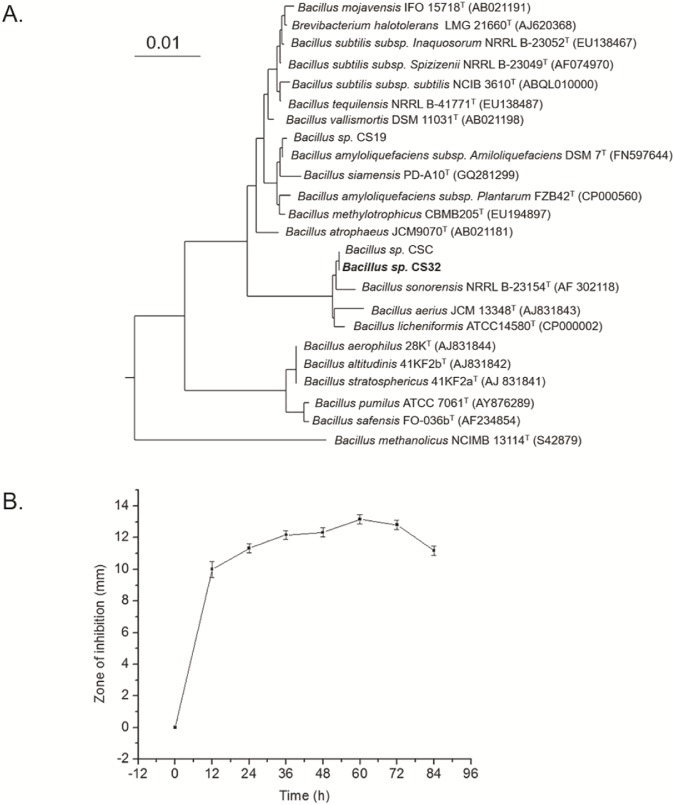
(A) A neighbor-joining tree based on nearly complete 16S rRNA gene sequences showing relations between strain CS32 and related members of the genus Bacillus. The percentages at the nodes are the levels of bootstrap support based on neighbor-joining analyses of 1000 resampled datasets. The sequence of Bacillus licheniformis ATCC 14580(T) served as an outgroup. The scale bar: 0.01 nucleotide substitutions per position. (B) Production of CSP32 and the growth-inhibitory activity against Mycobacterium smegmatis ATCC 9341. The antibacterial activity is maximal at 60 h. The zone of inhibition against Mycobacterium smegmatis ATCC 9341 at every 12 h is shown. Cultivation was carried out in 250-mL flasks with 50 mL of a medium, at pH 7 and 37°C, with shaking at 180 rpm.